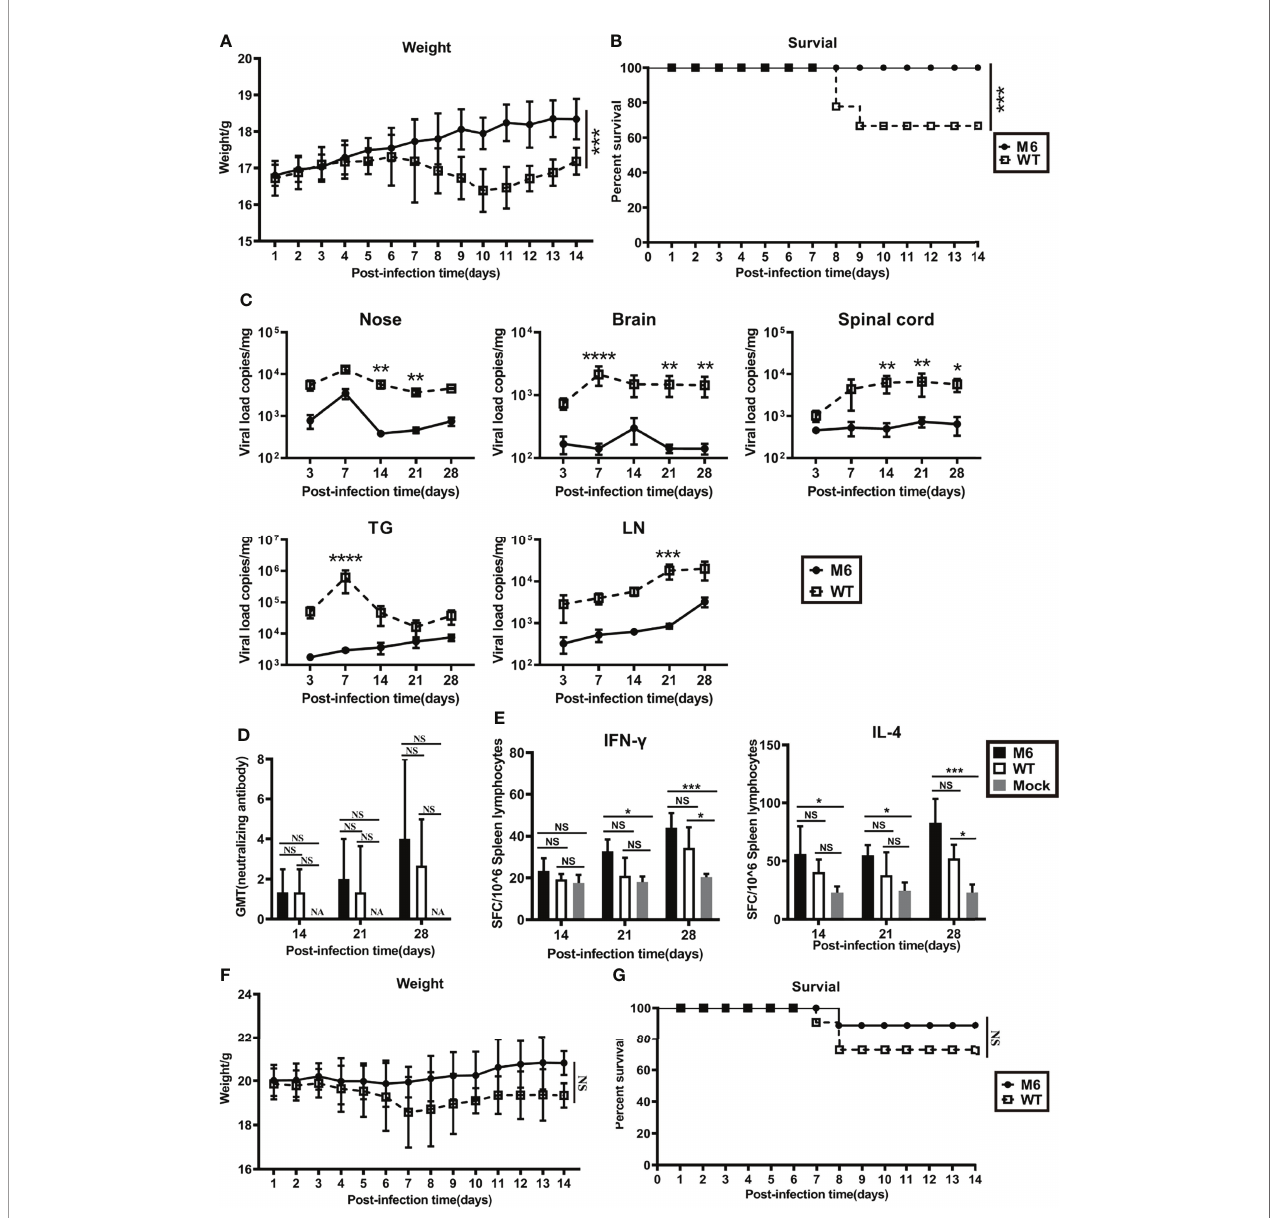
FIGURE 1 | The mutated strain M6 produced a more effective immune response than the wild-type strain. Bodyweight (A) and survival rate (B) of mice infected with the attenuated HSV-1 mutant M6 (circle) and the wild-type strain (square) via nasal spray. (C) Viral loads in the nose, brain, spinal cord, trigeminal ganglion, and inguinal lymph node after infection with M6 (circle) and WT (square), as determined by RT – qPCR. (D) The HSV-1 neutralizing antibody titer in mice infected with M6 (black square), WT (white square), and Mock (gray square). (E) The ELISpot responses show IFN- g - and IL-4-secreting cells among splenic lymphocytes after infection with M6 (black square), WT (white square), and Mock (gray square). Bodyweight (F) and survival rate (G) of mice immunized with M6 (circle) and WT (square) after wild-type viral challenge. The data are shown as the mean ± SEM based on data from three independent experiments. * P < 0.05, ** P < 0.01, *** P < 0.001, **** P < 0.0001. NS, no signi fi